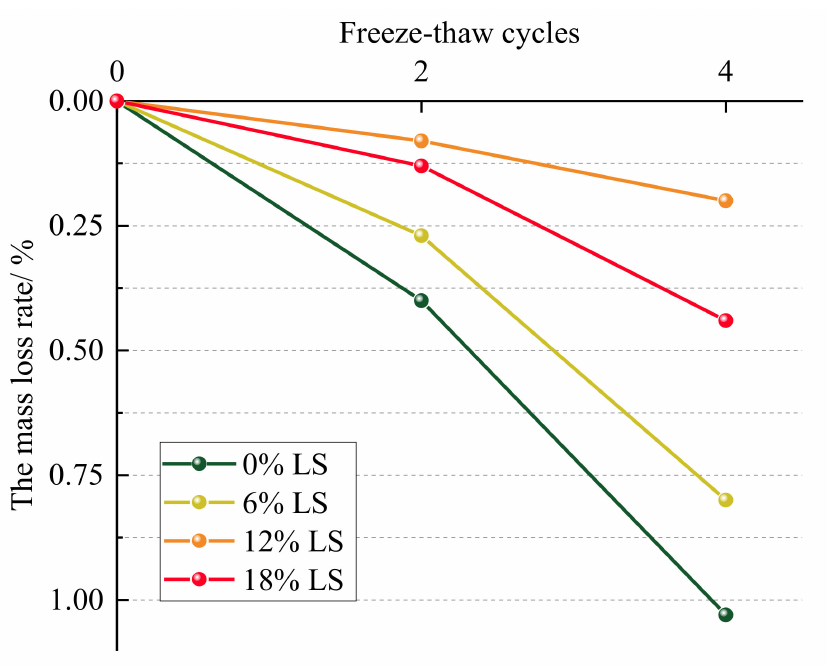
Figure 5. Effect of LS content on mass loss of cement-soil after freeze–thaw